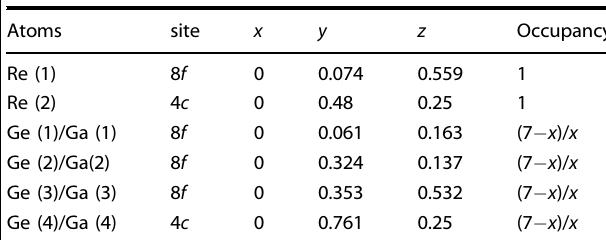
Table 1. Atomic coordinates for Re 3 Ge 7 − x Ga x